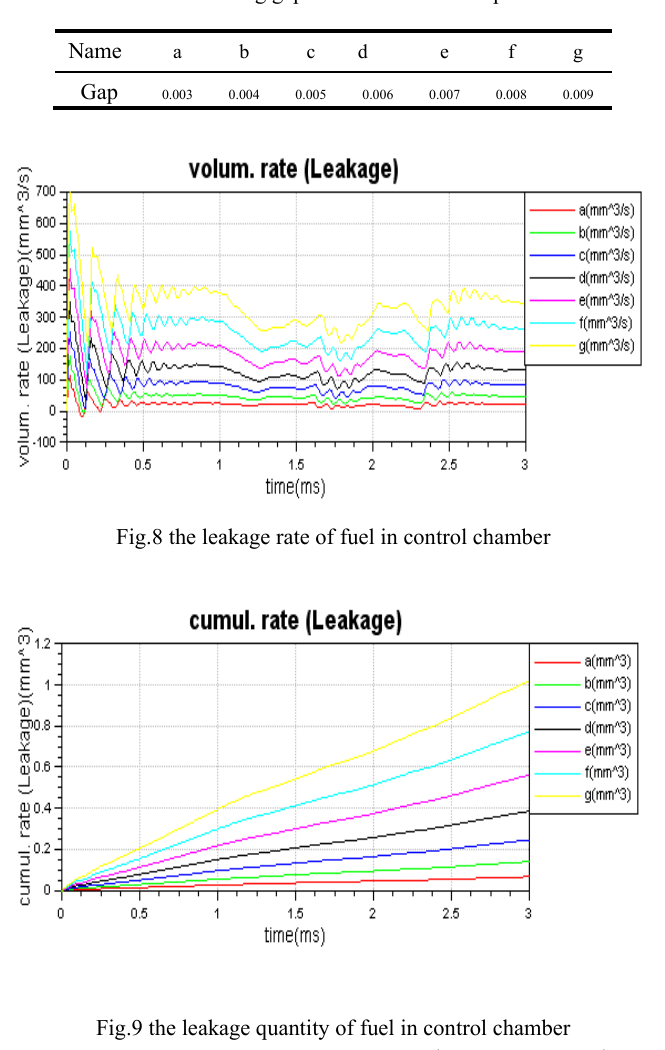
Fig.9 the leakage quantity of fuel in control